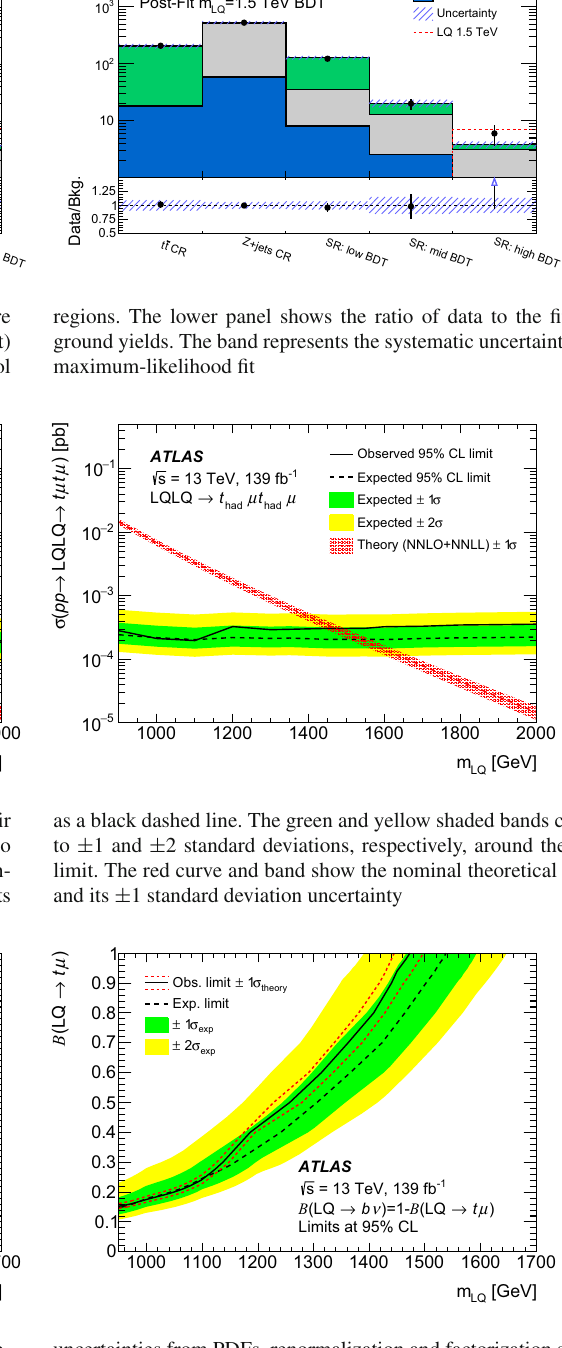
uncertainties from PDFs, renormalization and factorization scales, and the strong coupling constant α S . Expected limits are indicated with a black dashed curve, with the yellow and green bands indicating the ± 1 standard deviation and ± 2 standard deviation excursions due to exper- imental and modelling